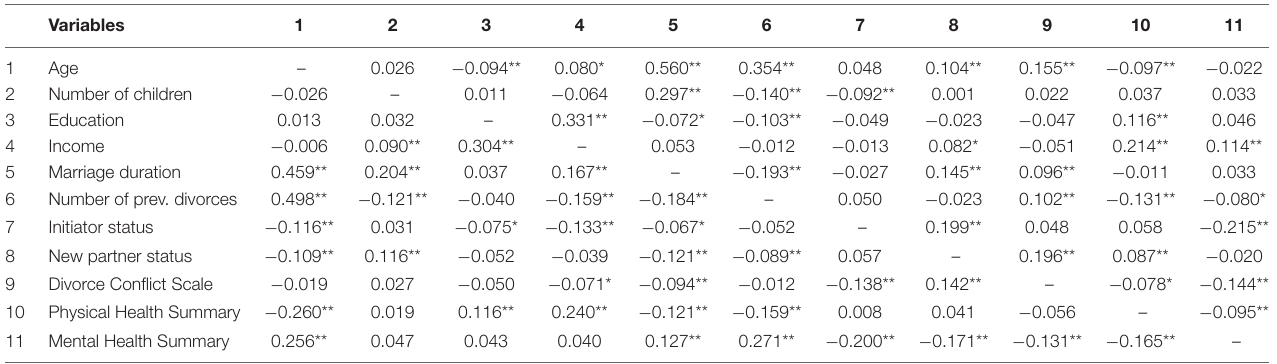
TABLE 2 | Correlations among sociodemographic variables, divorce conflict scale scores, physical and mental health summary scores ( N = 1856, men n = 617, women n = 1239).